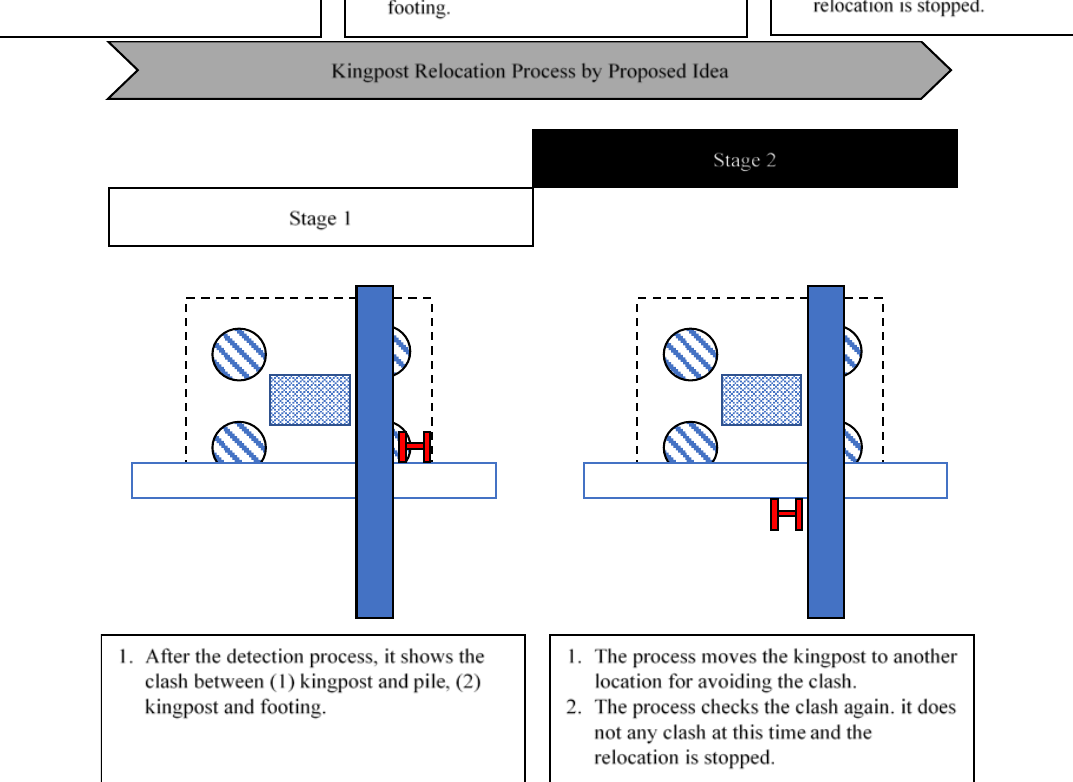
Figure 4. A comparison of kingpost relocation by using the available construction program and the proposed idea.